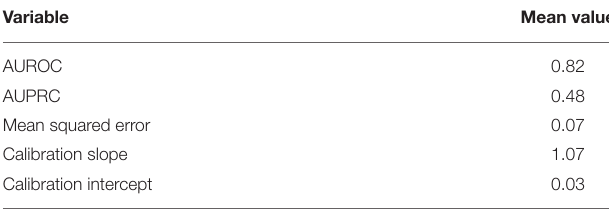
TABLE 5 | Cross validation